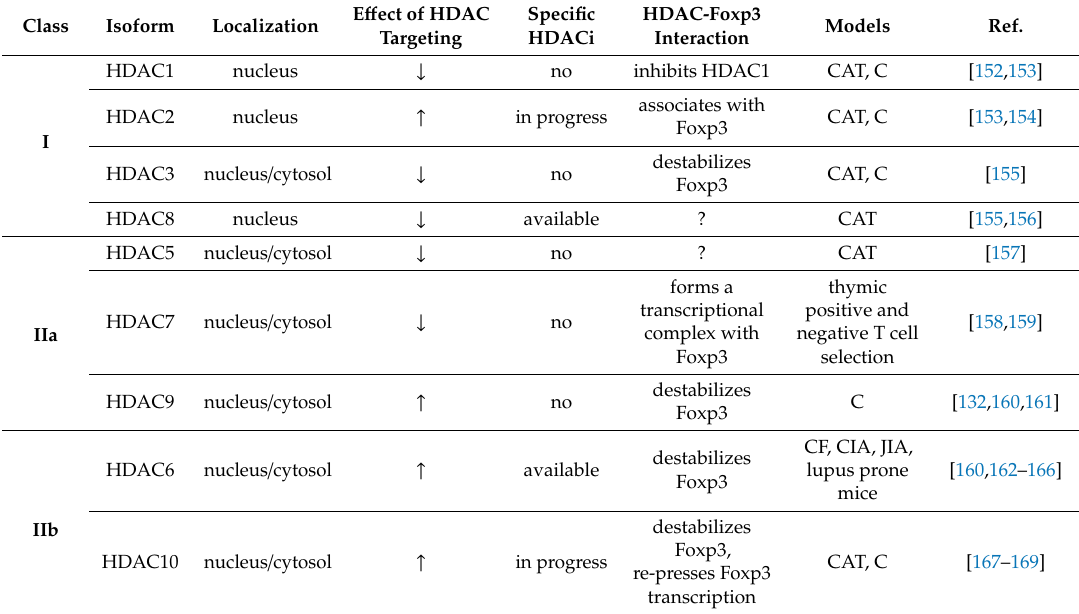
Table 2. HDAC isoforms expressed in T regs promoting / attenuating their function. (C, colitis; CAT, cardiac allograft transplantation; CF, cystic fibrosis; C / JIA, collagen / juvenile-induced arthritis; CLP, cecal ligation and puncture; MCAO, mouse transient middle cerebral artery occlusion.) E ff ect of HDAC Specific HDAC-Foxp3 Class Isoform Localization Models Targeting HDACi Interaction